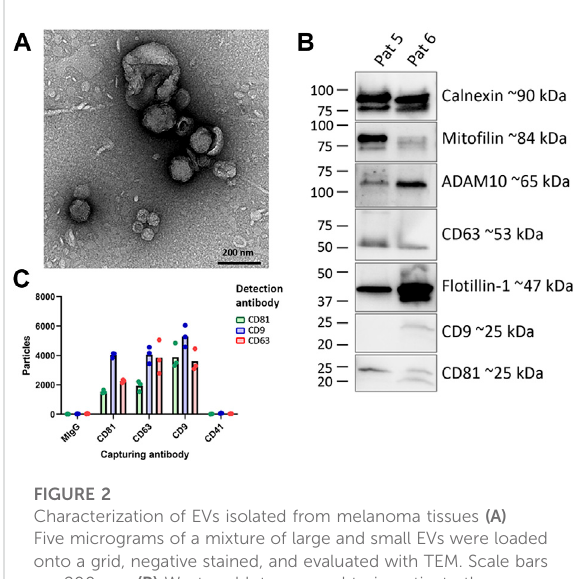
FIGURE 2 Characterization of EVs isolated from melanoma tissues (A) Five micrograms of a mixture of large and small EVs were loaded onto a grid, negative stained, and evaluated with TEM. Scale bars are 200 nm. (B) Western blot was used to investigate the presenceoftheclassicalvesiclemarkers fl otillin-1,CD63,CD9and CD81, mito fi lin, and ADAM10 as well as the ER protein calnexin in patient 5 and patient 6 (C) ExoView ™ analysis showing the presence of CD9, CD63, CD81, and CD41a on EVs. The results are presented as the mean, but individual values from three different spots on the chip (technical replicates) are shown (N =